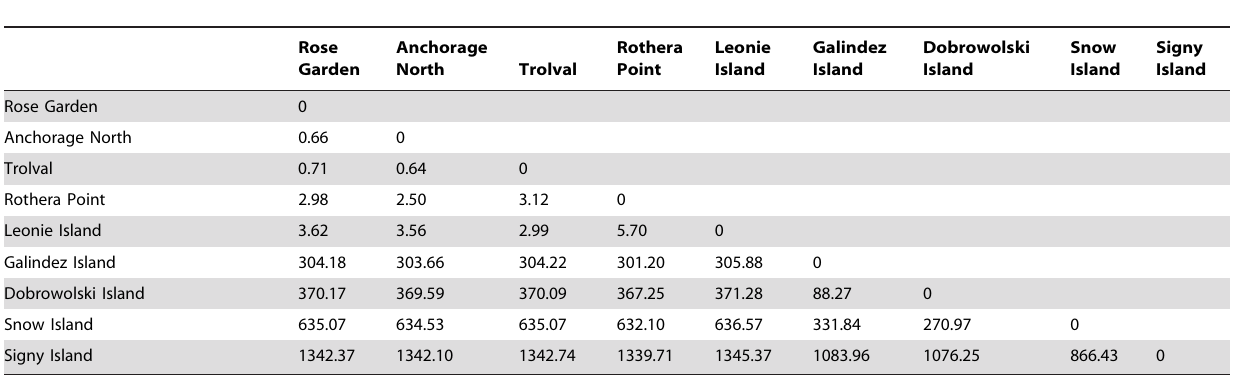
Table 2. Matrix of geographic distances among the nine M. antarctica sampling sites in